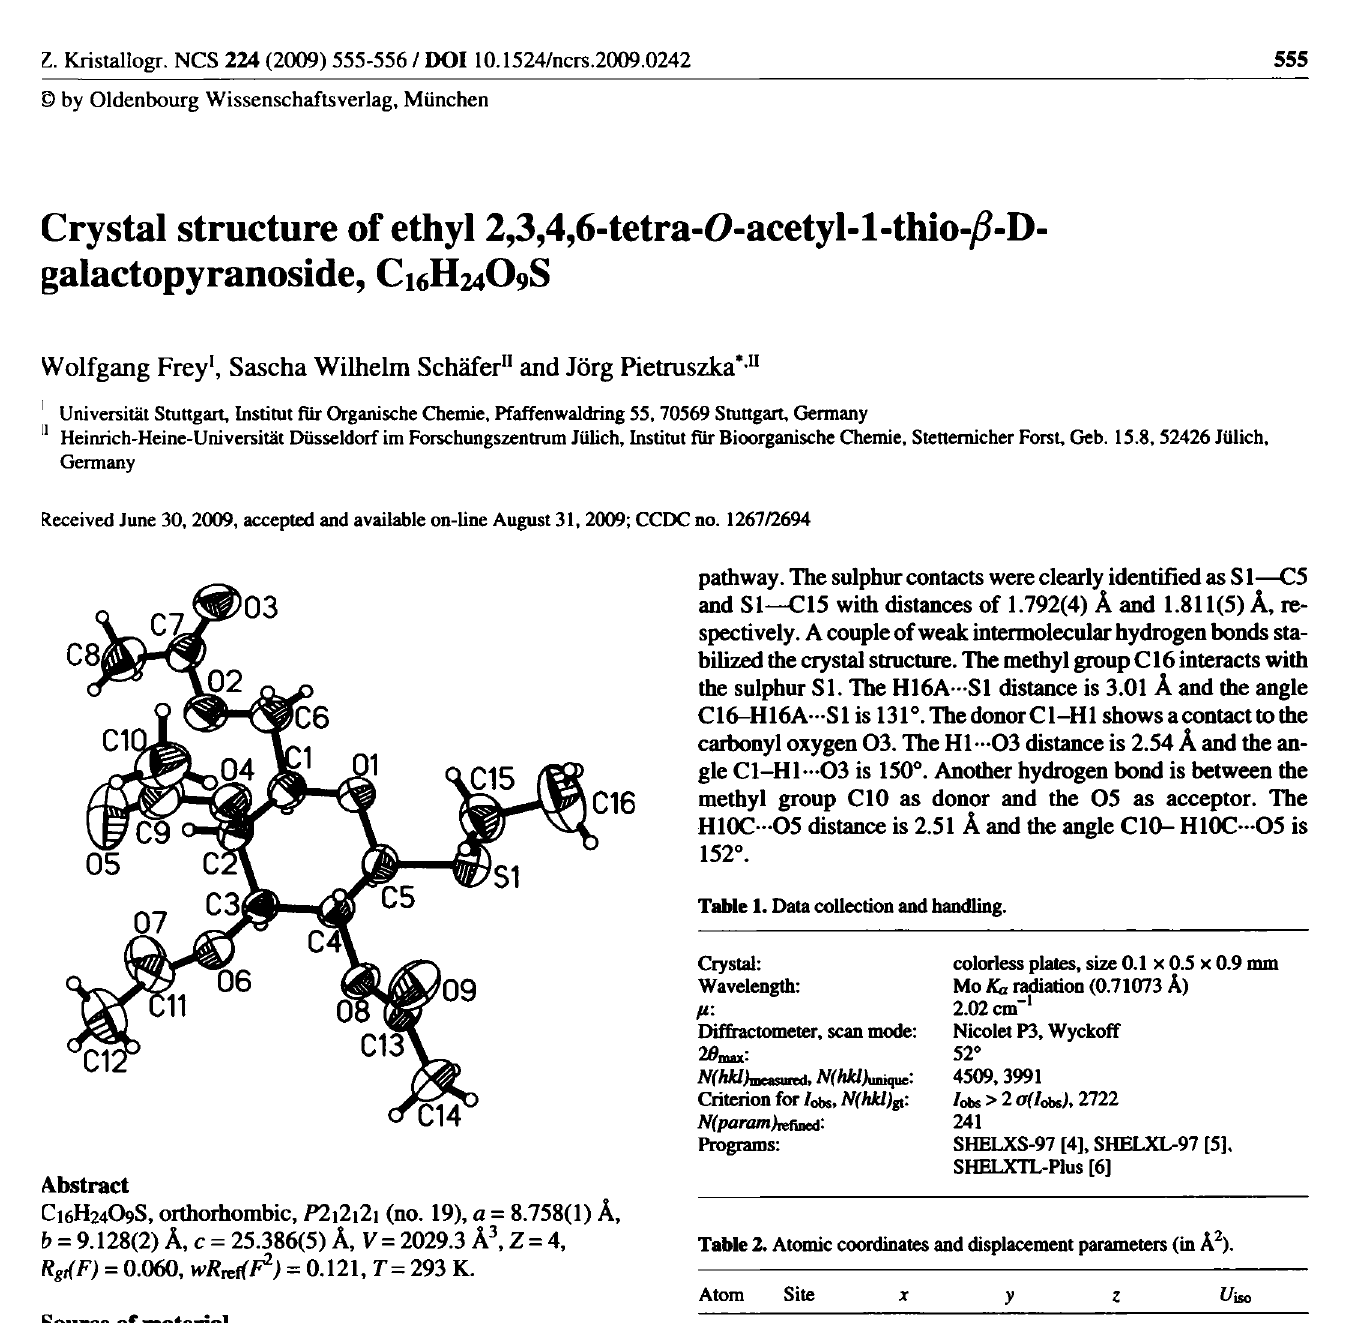
Table 2. Atomic coordinates and displacement parameters (in Â 2